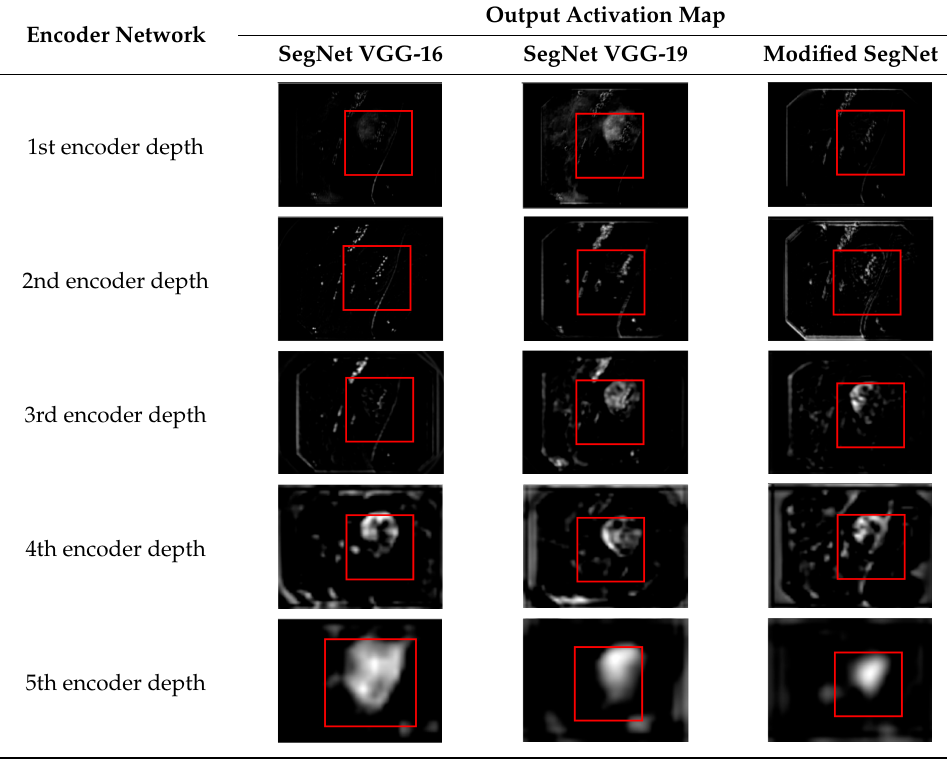
Figure A3. The image on the left is a raw colonoscopy image used for visualisation, and the image on the right represents the ground truth for the left image.